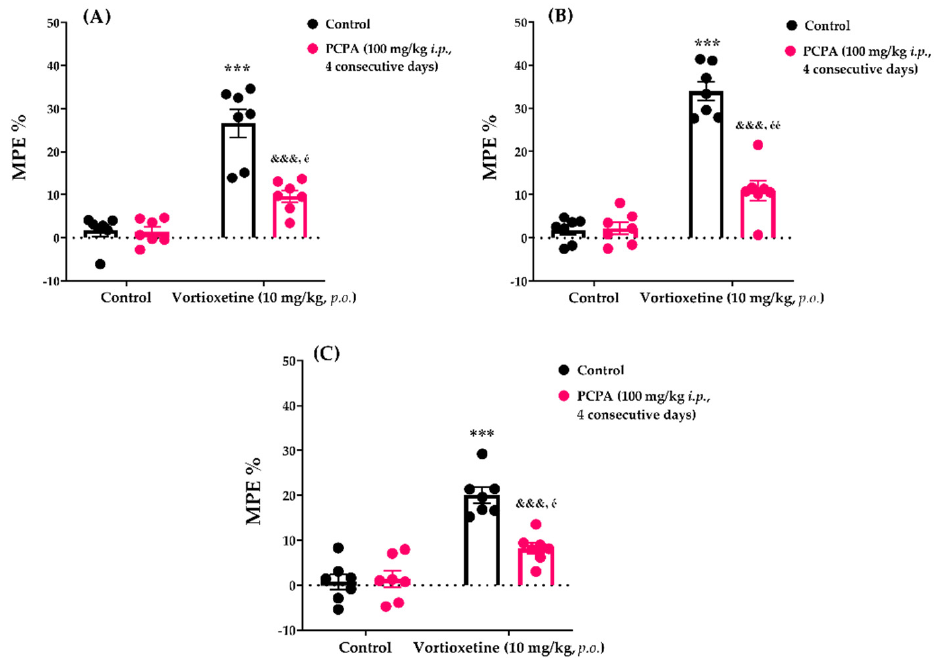
Figure 5. Involvement of serotonergic system in the analgesic effects of vortioxetine in the tail-clip ( A ), tail-immersion ( B ) and hot-plate ( C ) tests. Significant difference against vehicle treated control groups *** p < 0.001; Significant difference against vortioxetine administrated control groups &&& p < 0.001; Significant difference against PCPA administrated control groups é p < 0.05, éé p < 0.01. Two-way ANOVA, post-hoc Bonferroni test, n = 7.